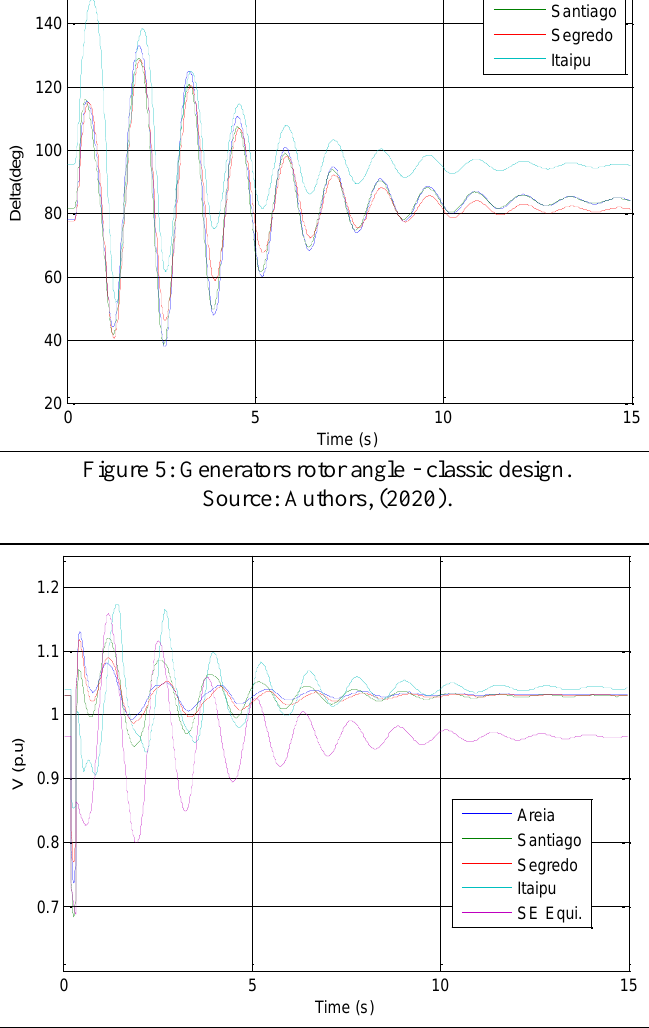
Figure 6: Generation bus voltage - classic design.